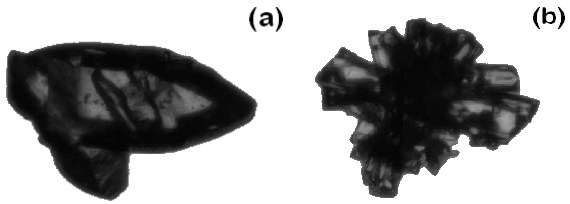
Figure 3. Example of the final morphology of the API. Dry samples are classified by SEM and optical microscopy: ( a ) mono-crystal (CE diameter: 233.2 µ m, length: 329.1 µ m, width: 207.5 µ m); and ( b ) star-shaped crystal (CE diameter: 191.5 µ m, length 247.5 µ m, width: 197.9 µ